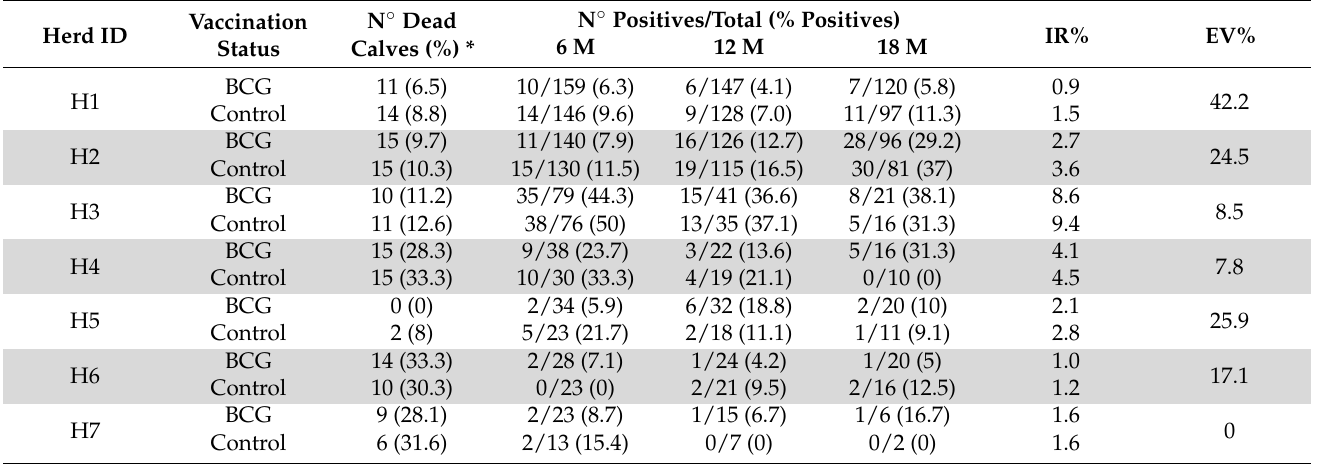
Table 1. Calf mortality, reactor animals, incidence rates (IR%) and efficacy of vaccine (EV%) in BCG-vaccinated and control animals per dairy herd.